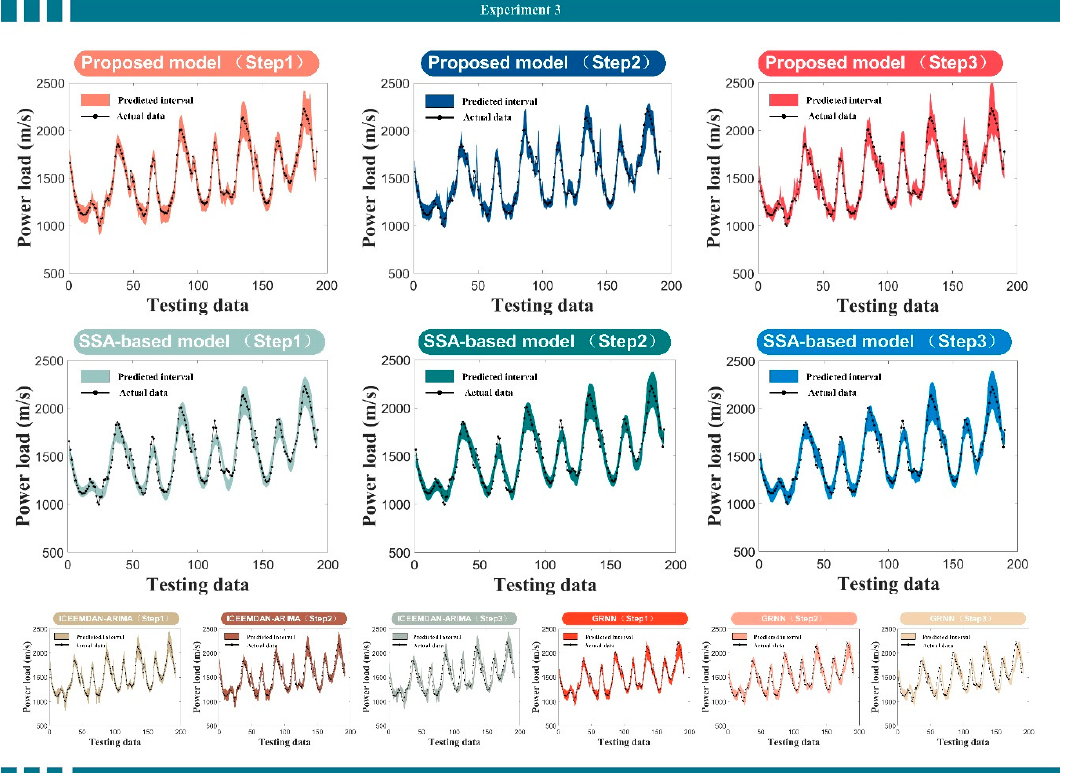
Figure 6. The final interval results of some models in multi-step forecasting in Experiment III for site 3. The figure shows the interval forecast results of the proposed model, singular spectrum analysis (SSA)-based model, Improved Complete Ensemble Empirical Mode Decomposition (ICEEMDAN)- Autoregressive Integrated Moving Average (ARIMA) model and Generalized Regression Neural Network (GRNN) single model, respectively. In addition, the figure shows the relationship between the interval forecasting band and the real